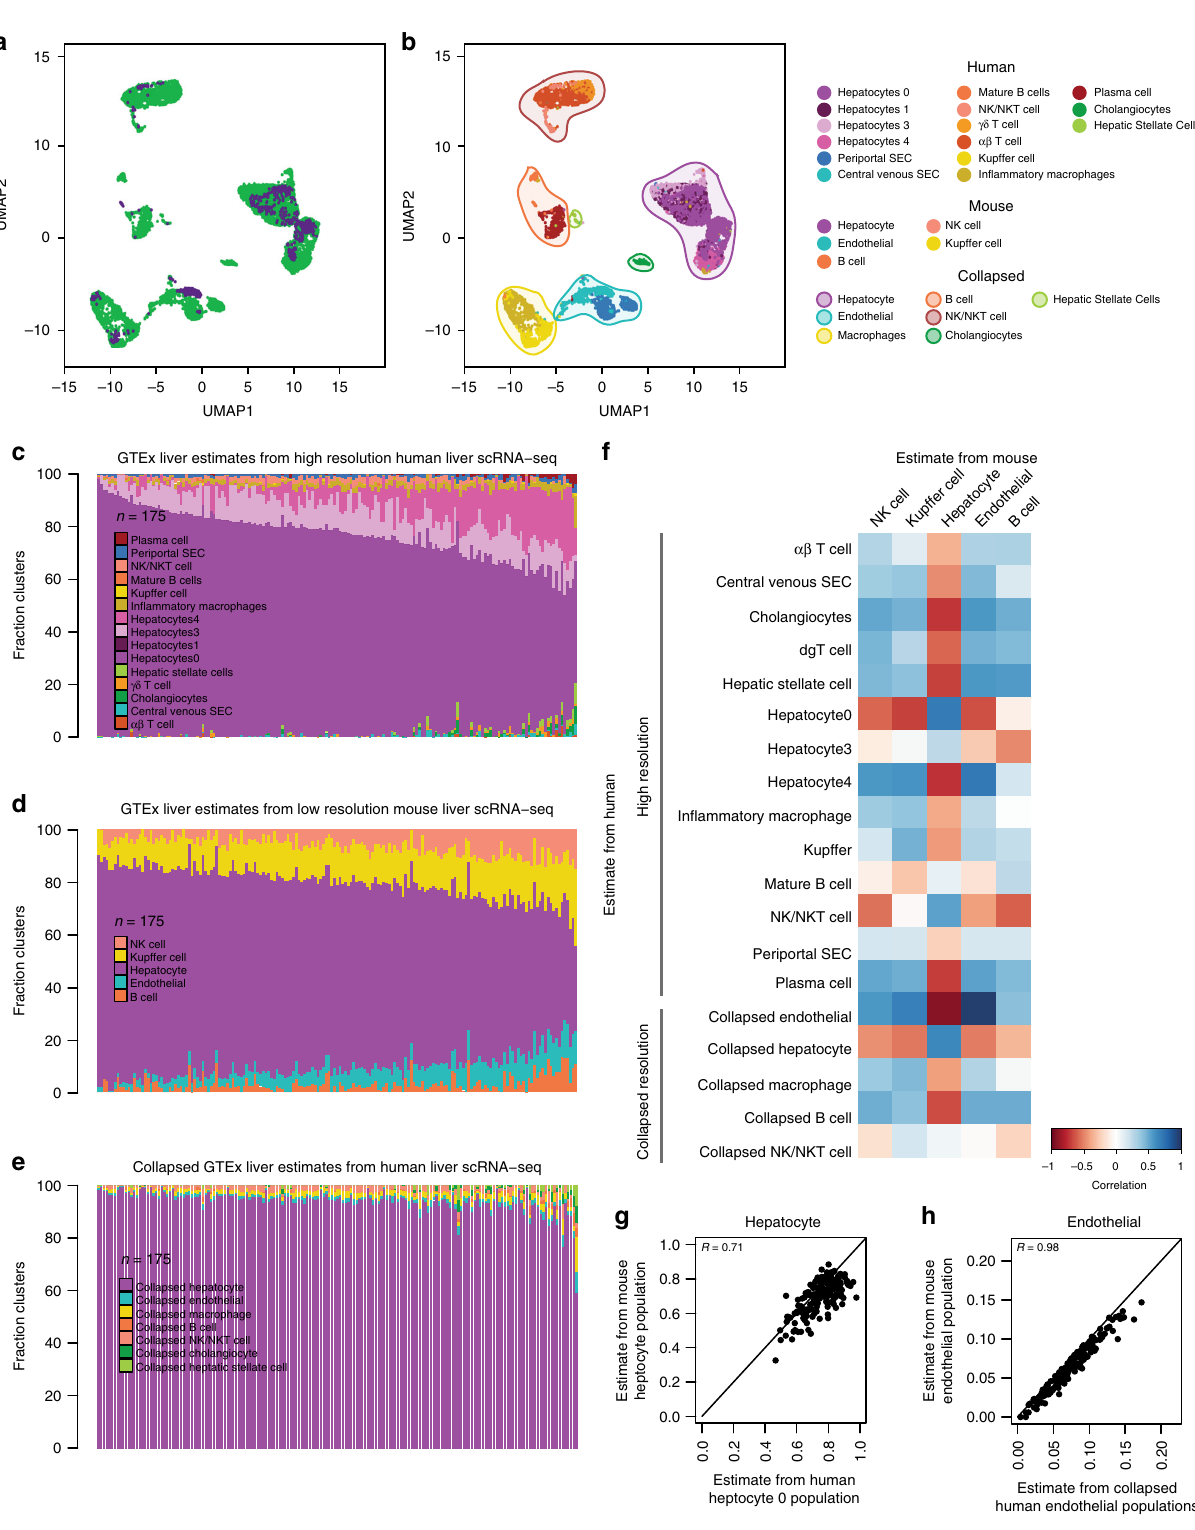
populations (1, 3, and 4); and was slightly less correlated with the liver samples from human (high and collapsed resolution collapsed hepatocyte population estimate ( r = 0.64, p -value = estimates) with the estimated cell populations from mouse 1.015 × 10 − 21 ) (Fig. 2f, g). This indicates that the low-resolution (low-resolution estimates) (Fig. 2f, Supplementary Fig. 1). We found that hepatocyte estimates from mouse liver were positively mouse hepatocyte population corresponds to one of the four and highly correlated with the human high-resolution hepatocyte human hepatocyte populations/zones potentially due to tissue 0 population estimate ( r = 0.71, p -value = 5.4 × 10 − 28 ), but not sampling. Further, we observed that the endothelial estimates correlated with any of the other three high-resolution hepatocyte from mouse were highly correlated with the collapsed human NATURE COMMUNICATIONS|